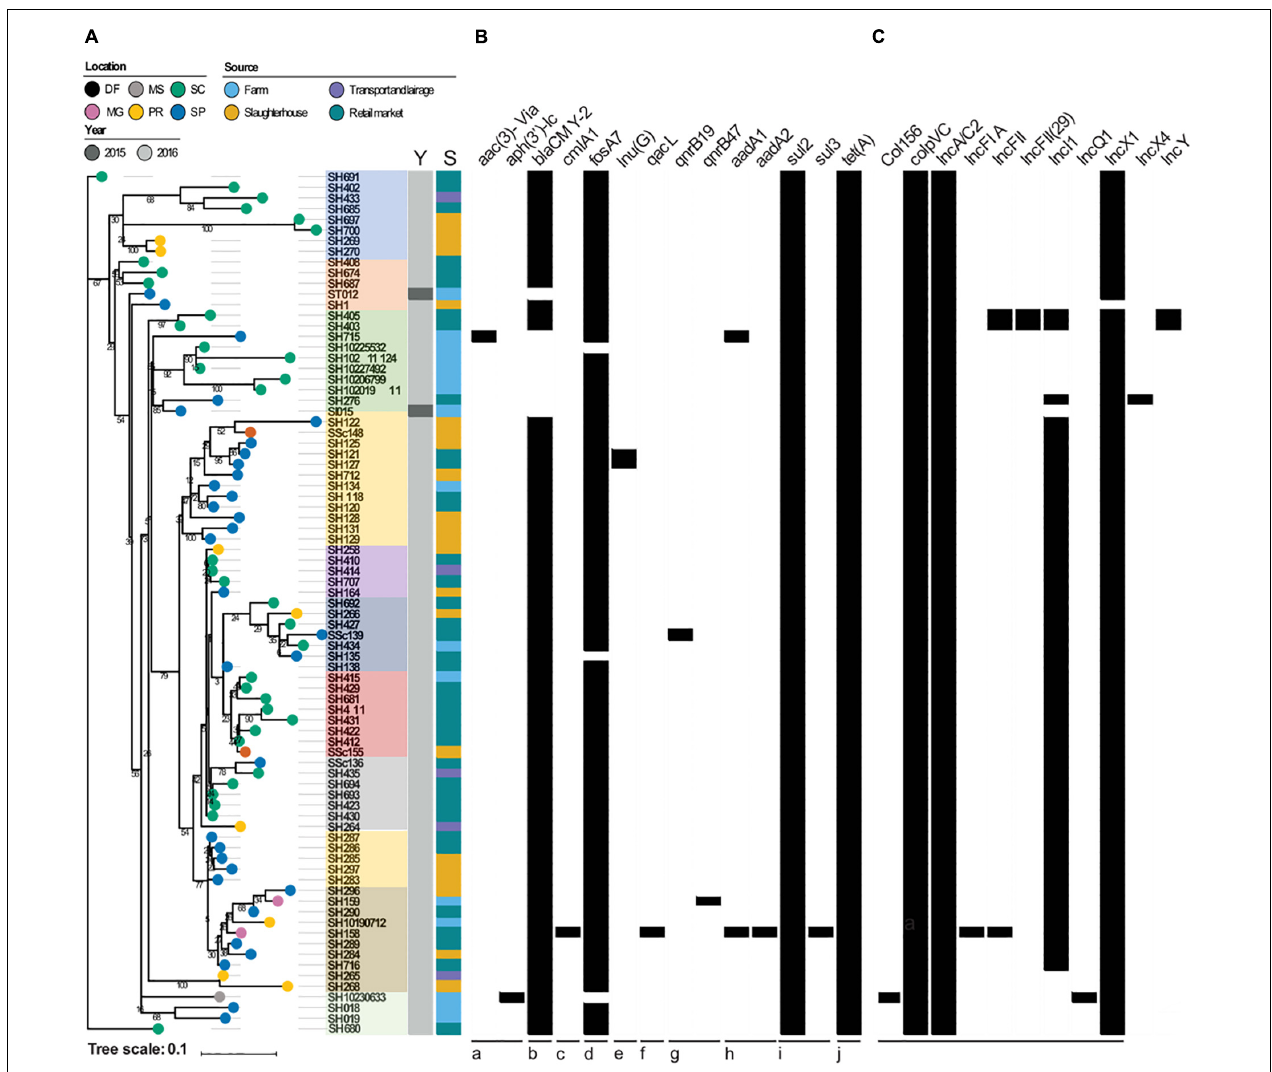
FIGURE 1 | (A) Reconstructed phylogeny based on the core genome (4,139 genes) of the 81 S . Heidelberg strains. The percentage of bootstrap samples in which nodes appeared is shown. The location of isolation of each strain is labeled on its respective branch. Color strips depict the year (Y) and source (S) of isolation, respectively. (B) The presence and absence of selected antimicrobial resistance genes are shown, with black indicating presence. The drug classes impacted by these genes are: (a) aminoglycosides, (b) beta-lactams, (c) chloramphenicol, (d) fosfomycin, (e) lincosamide, (f) quaternary ammonium compounds, (g) quinolones, (h) streptomycin, (i) sulfonamides, (j) tetracylines. (C) Presence and absence of plasmid incompatibility groups, with black indicating presence. Brazilian States: PR, Paraná; SC, Santa Catarina; SP, São Paulo; MG, Minas Gerais; DF, Distrito Federal; MS, Mato Grosso do